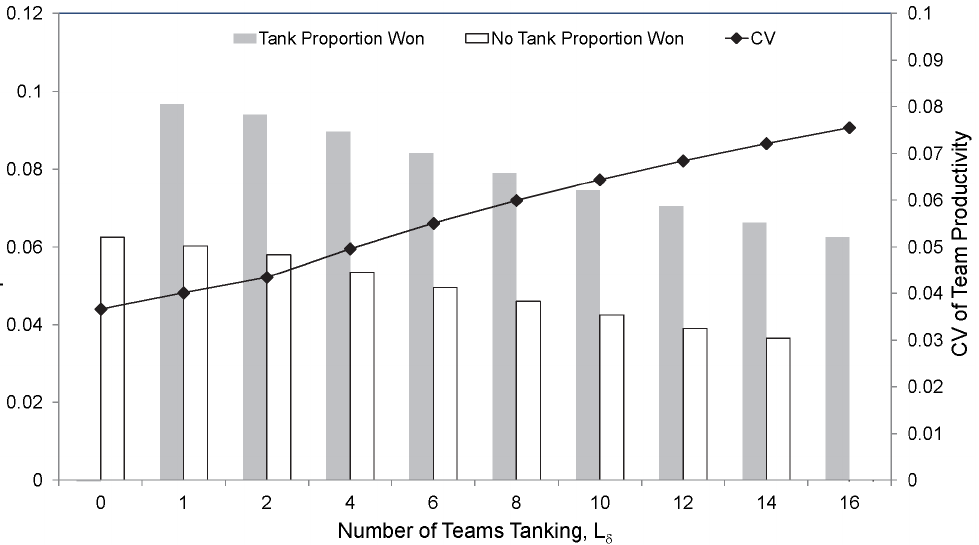
Figure 4. The proportion of premierships won for teams that tank (grey) and do not tank (white) as a function of the number of teams tanking. Also shown is the mean coefficient of variation of the team productivities for a particular year across all teams, years and